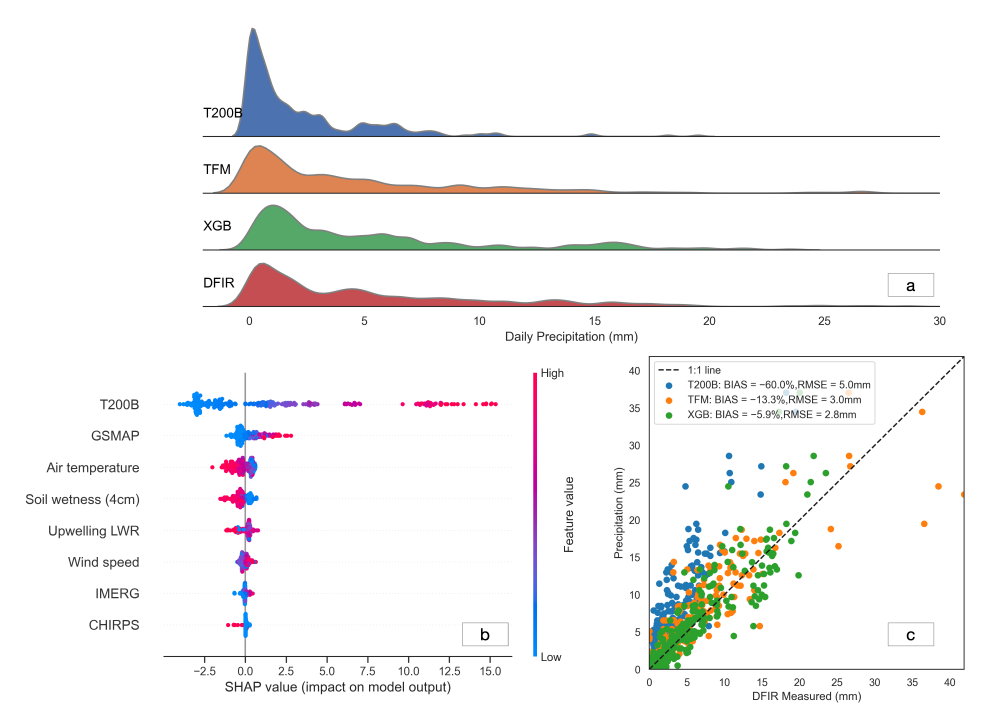
Figure 9. The corrected precipitation results by integrating the remotely sensed precipitation (GSMAP, IMERG, and CHIRPS). ( a ) The frequency distributions of precipitation datasets using the XGB and TFM methods of the T200B and the DFIR. ( b ) The importance of explanation using SHAP values. Each line in the graph represents a feature; the horizontal coordinates are SHAP values. A dot represents a sample. The redder the color, the larger the value of the feature itself. The bluer the color, the smaller the value of the feature itself. ( c ) The comparison between the corrected precipitation and the truth value using the DFIR observation. The accuracies (BIAS and RMSE) are listed in the upper